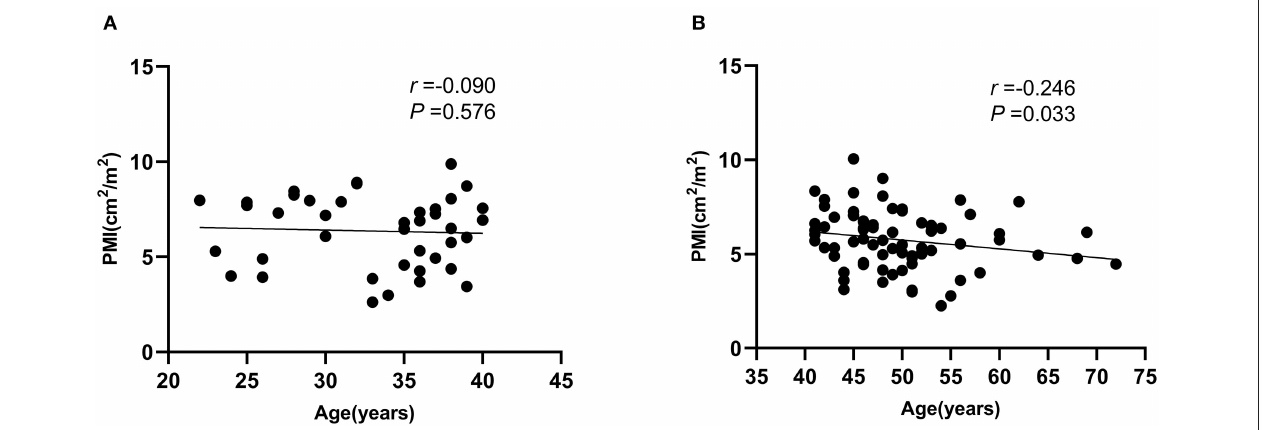
FIGURE 3 | Correlation between psoas muscle index (PMI) and age in different age subgroups in male ACLF patients. (A) Age ≤ 40 years, (B) Age > 40 years.